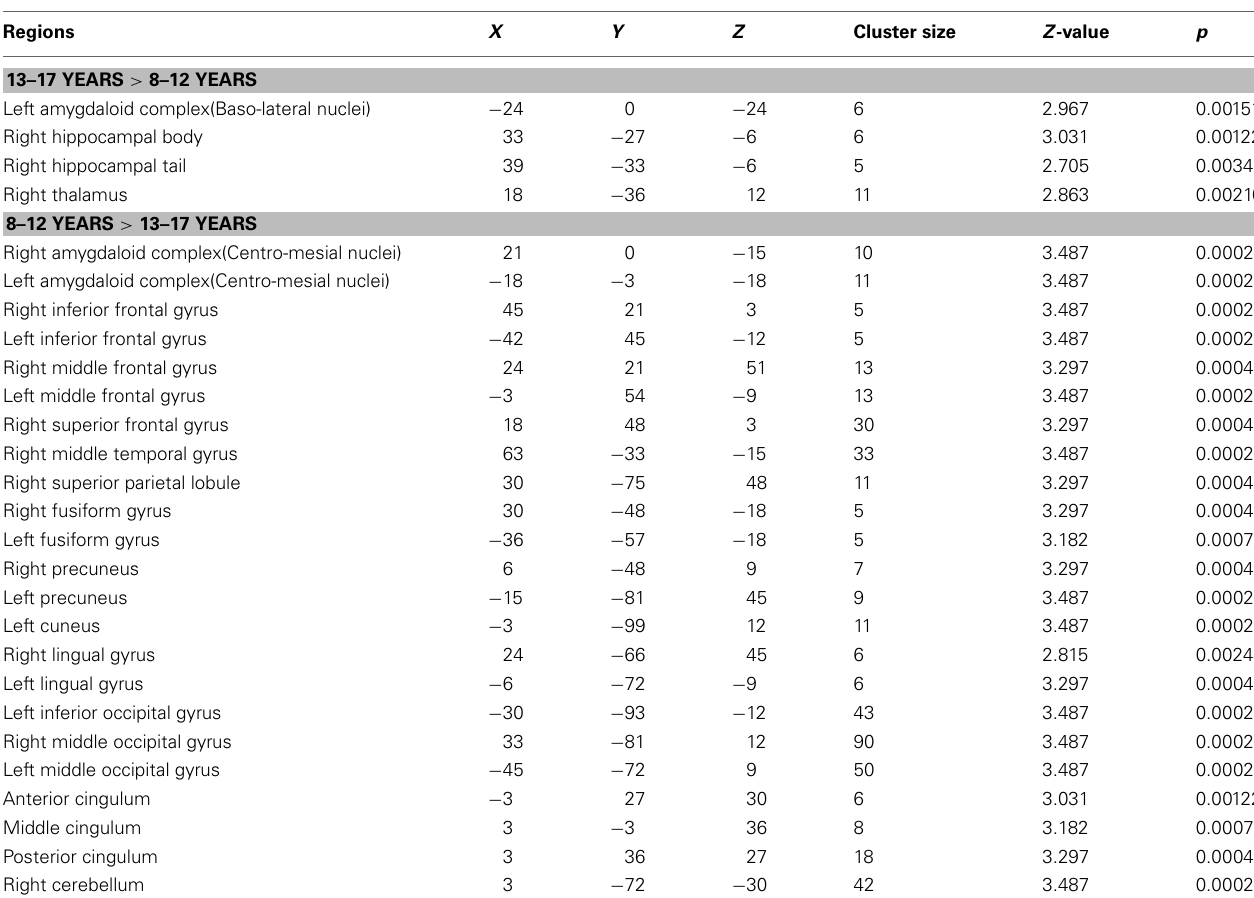
Table 1 | Neural substrates of subsequent memory effect (Dm) for fearful faces across ages. Regions